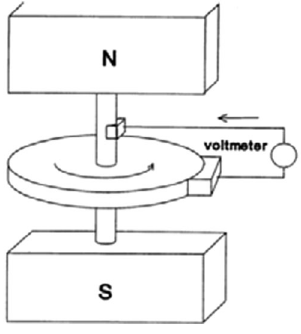
FIG. 7. A magnet is moving towards a conducting coil which is at rest from our observation.